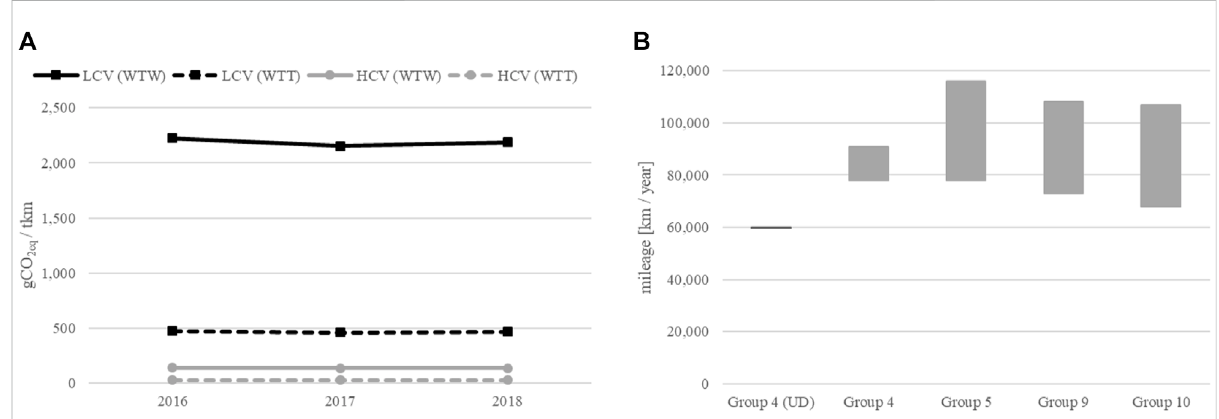
FIGURE 1 LevelofGHGemissions byroadfreightvehicle (A) andtruckmileagebygroup (B) .Noteontherightchart:thedatashowsthevaluesassociated with regional delivery (RD; bottom of the bar) and long-haul (LH; top of the bar) for each vehicle group. The exception is the fi rst bar, which re fl ects only urban delivery (UD). Source: adapted from data in EEA (2020) (A) and EU (2019) (B) .